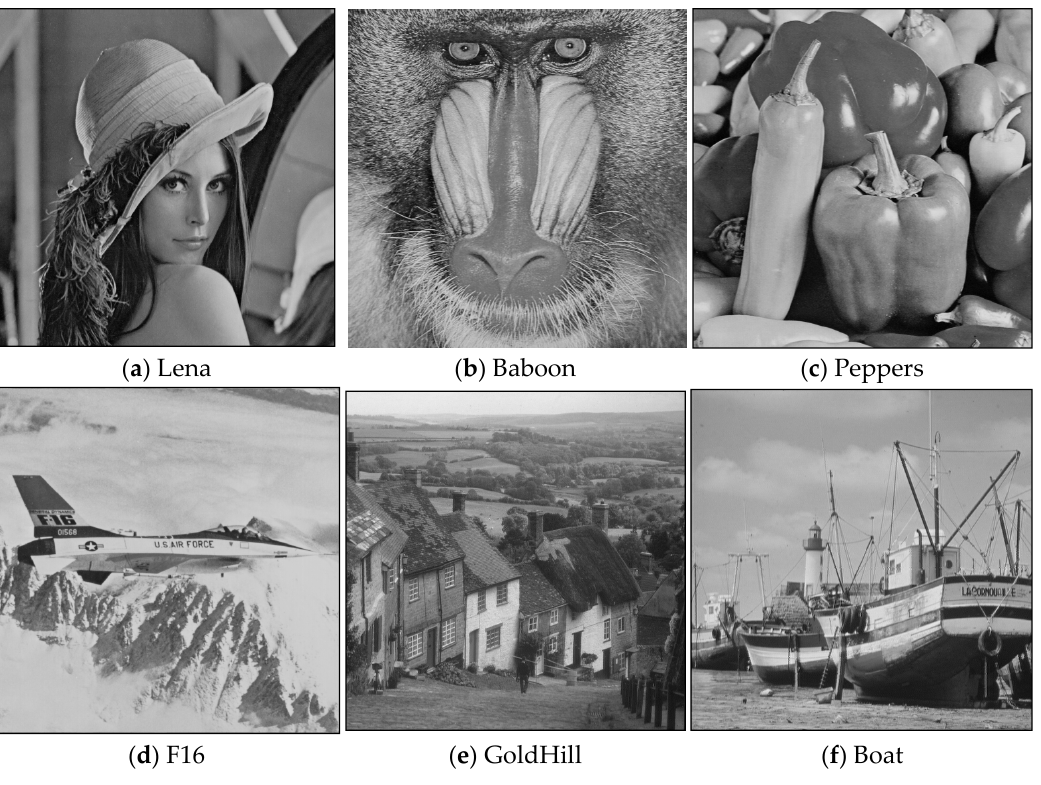
Figure 8. Six test grayscale images sized 512 × 512. Table 1. Performance of the proposed scheme under difference values of